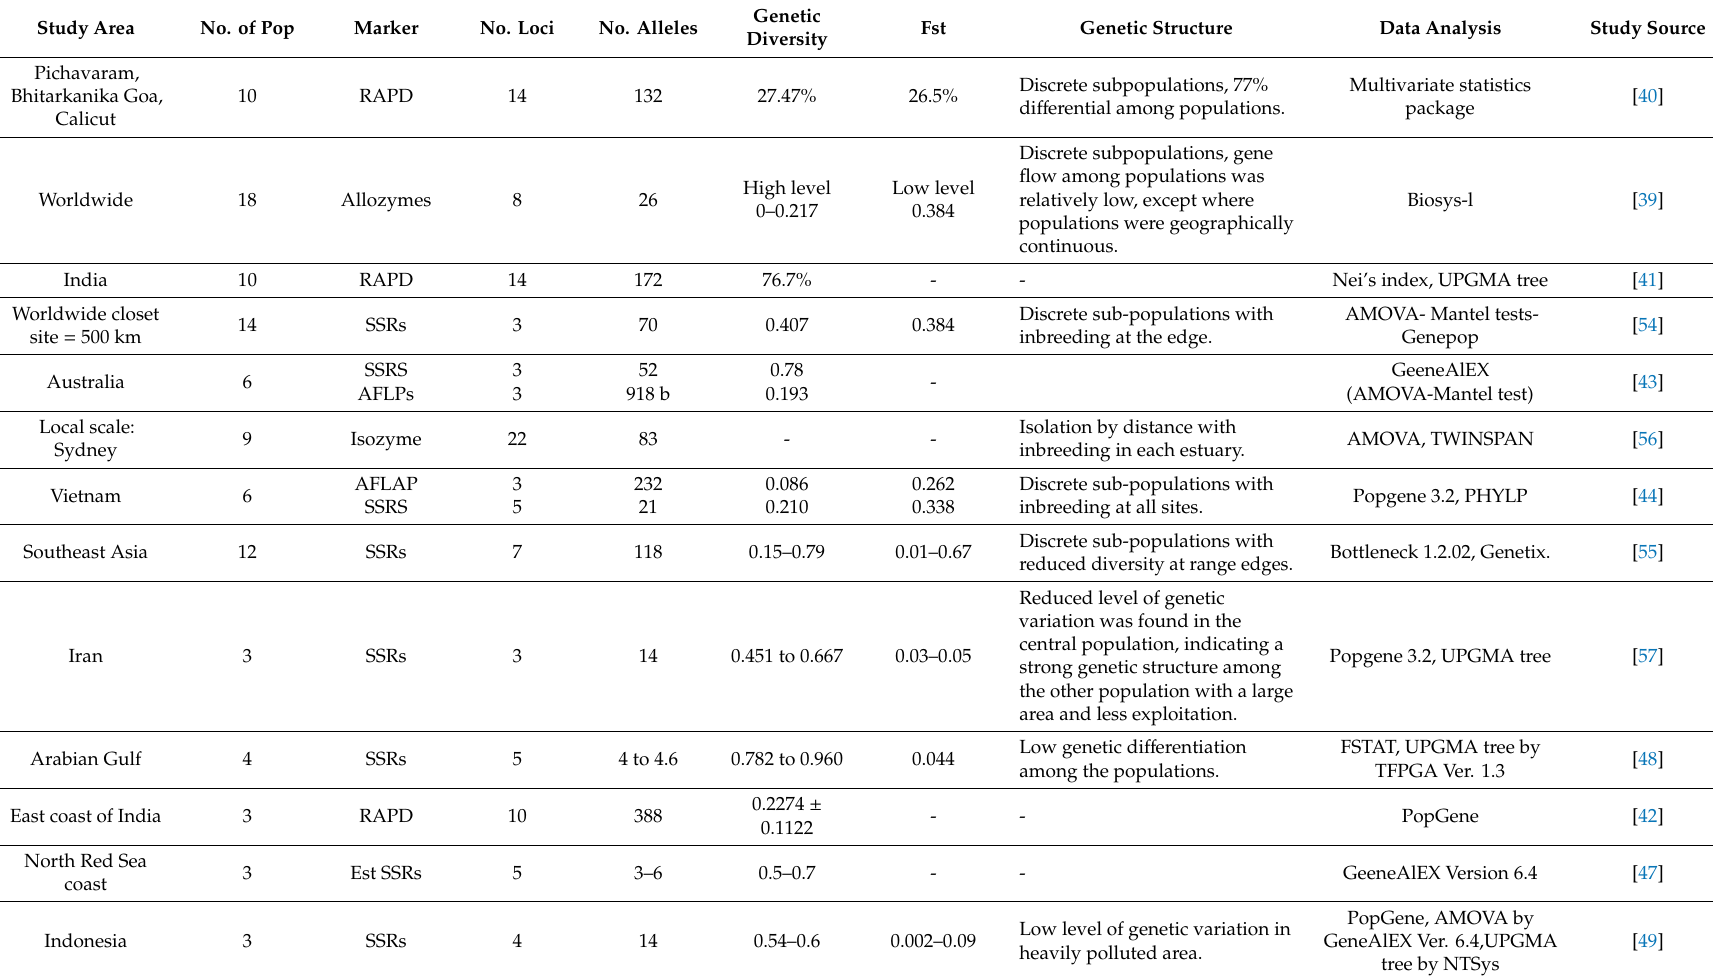
Table 1. Summary of the findings from genetic variation and genetic structure studies on A.